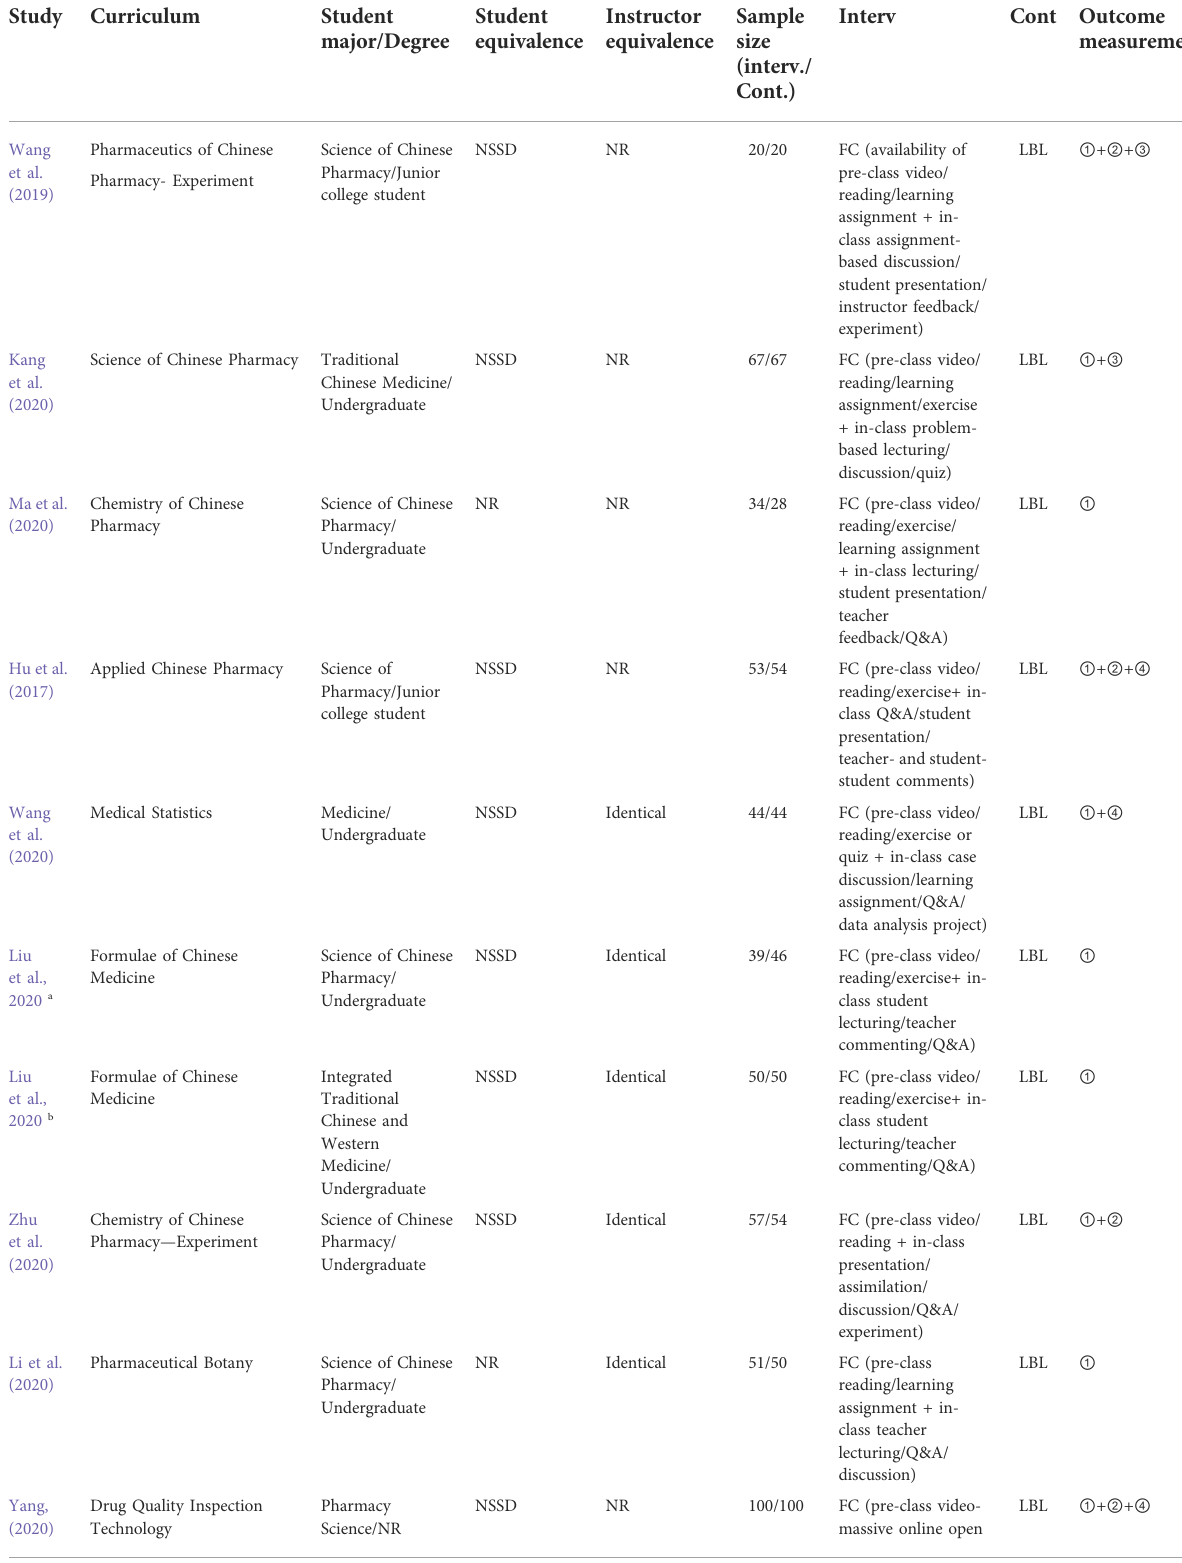
TABLE 2 Characteristics of the included